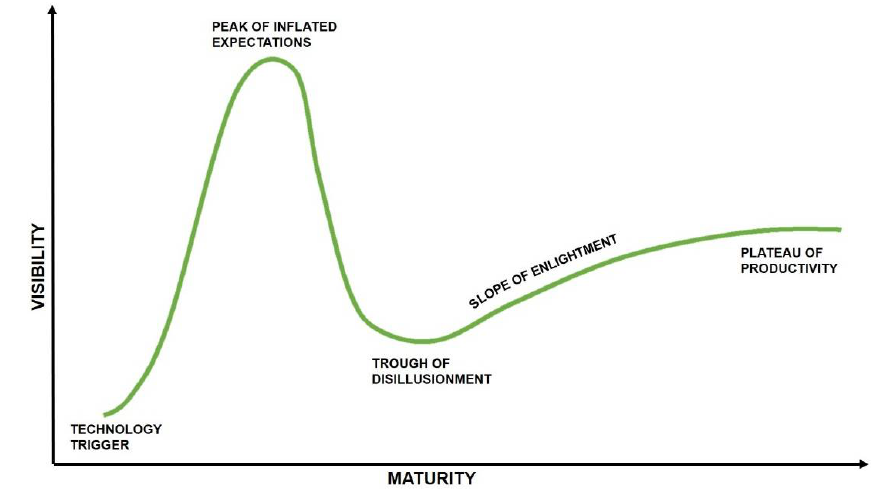
Figure 2. Gartner technology hype cycle (adapted from [38]).